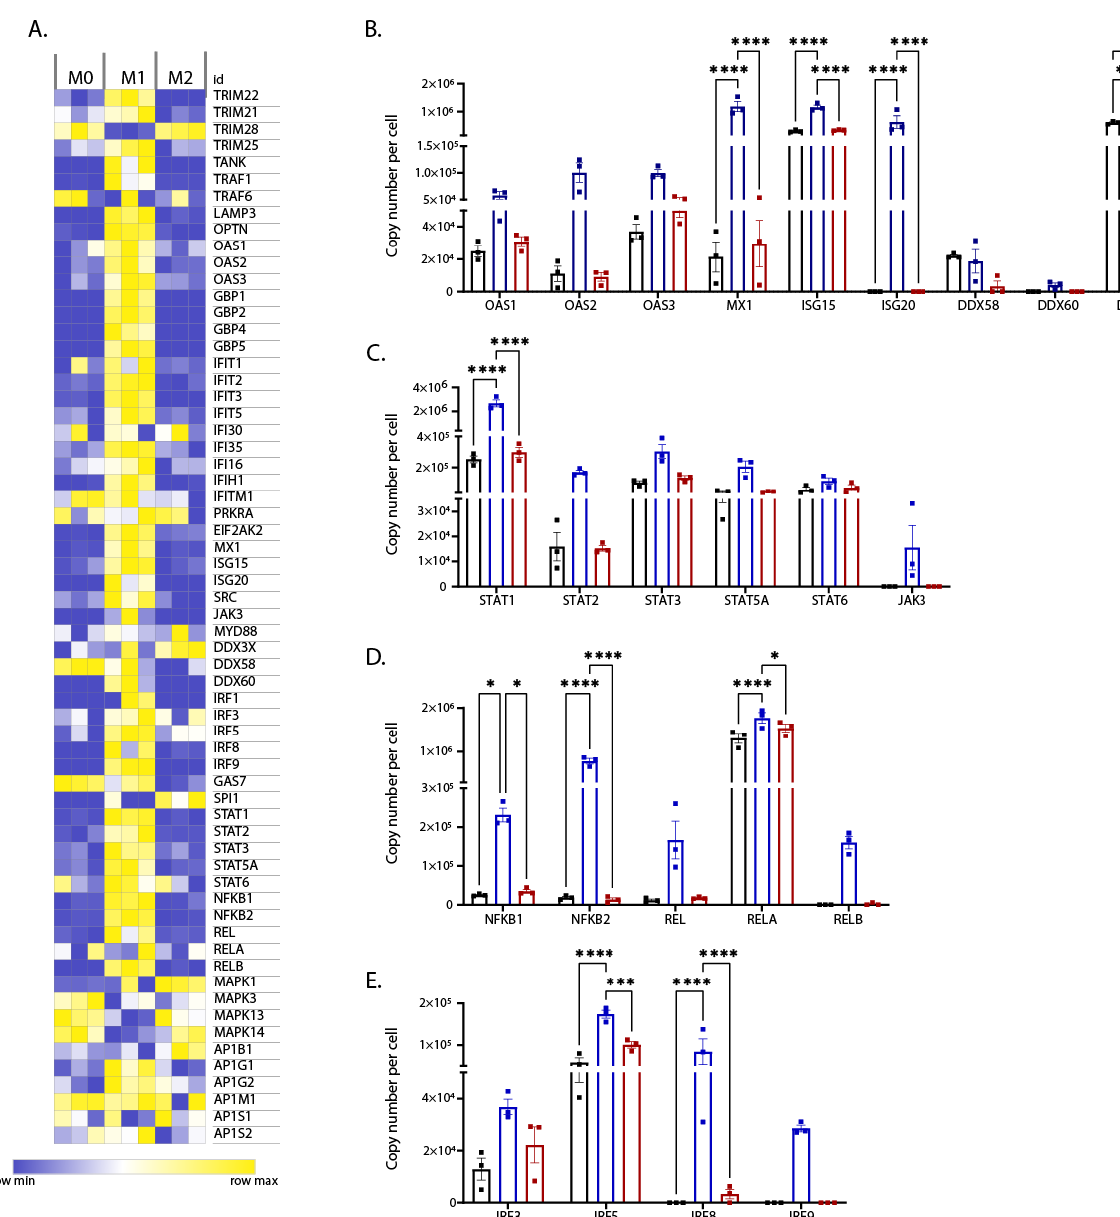
Figure 7. Differential expression levels of proteins involved in interferon (IFN) signalling. ( A ) Heat map showing differential expression of IFN regulated genes (concentrations in nM) across biological replicates of differentially polarised iPSDM. ( B – E ) Graphs show the estimated copy numbers per cell using the proteomic ruler method. p values: * 0.05, ** 0.01, *** 0.001, **** 0.0001.